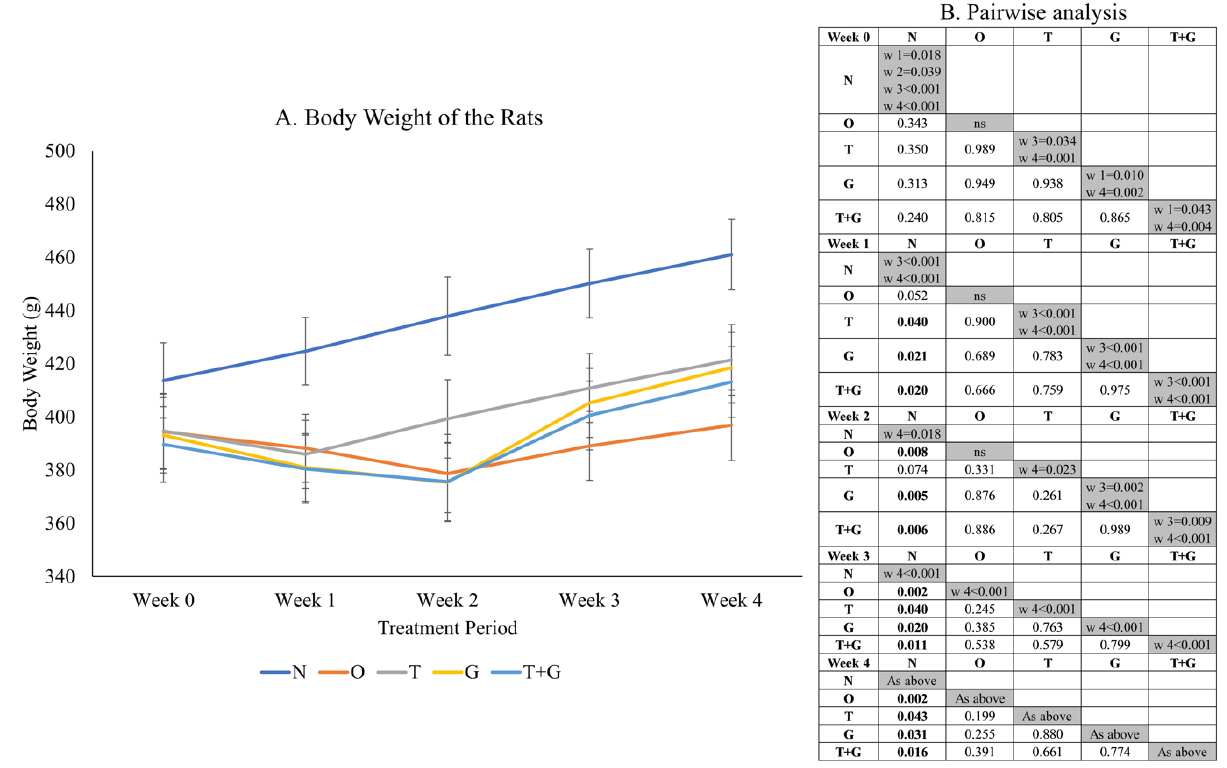
Figure 2. Body weight (mean ± standard error) of the rats throughout the study ( A ). The results of inter- ( p -values) and intra-group comparisons (weeks that show a significant difference) obtained from mixed-design analysis of variance are depicted in ( B ). The values in the shaded area indicate a significant difference of the group at that week compared to other weeks (0–4). The significant difference is defined at p < 0.05. Abbreviation: N: normal control; O: osteoarthritis control; T: